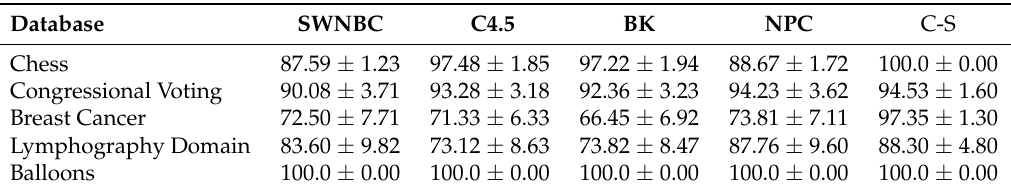
Table 5. Accuracy results in identification of categorical data for the comparison methods versus the C-S approach. SWNBC corresponds to the sparse weighted naive Bayes classifier [14], C4.5 is the coupled attribute similarity method [19], BK is the classifier based on Boolean kernel [20], and NPC is the naive possibilistic classifier